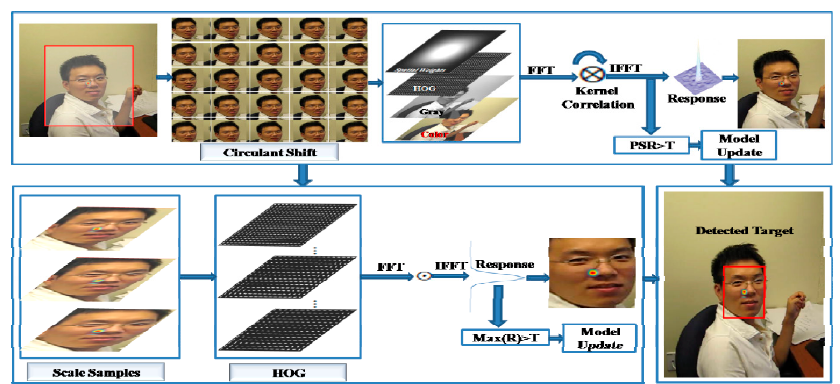
Figure 1. Block diagram of our proposed method.